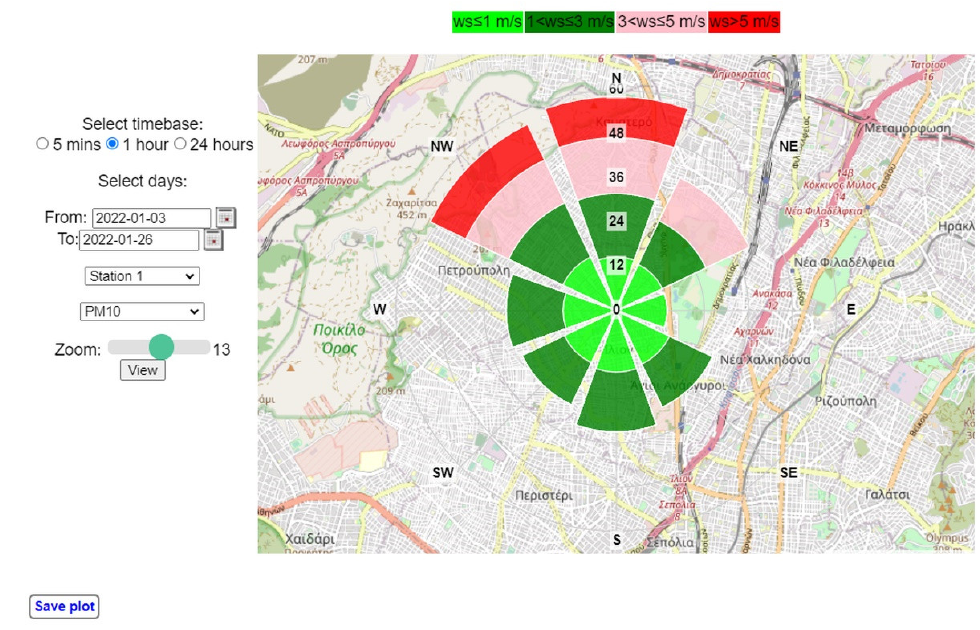
Figure 5. Pollution rose diagram.